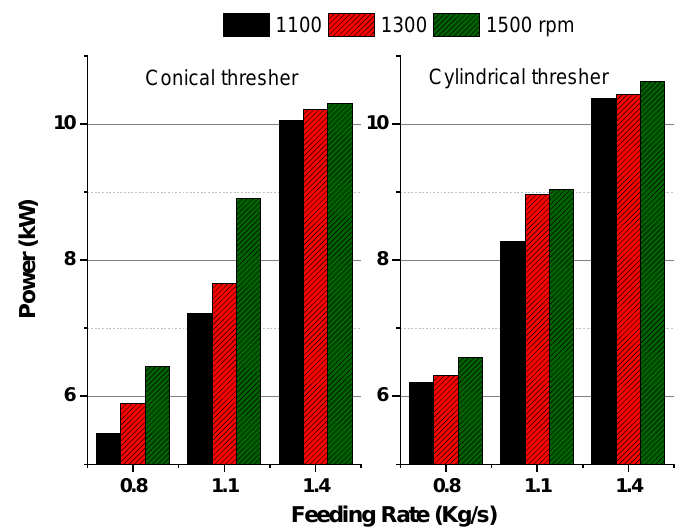
Figure 9. Effect of operating parameters on threshing power.